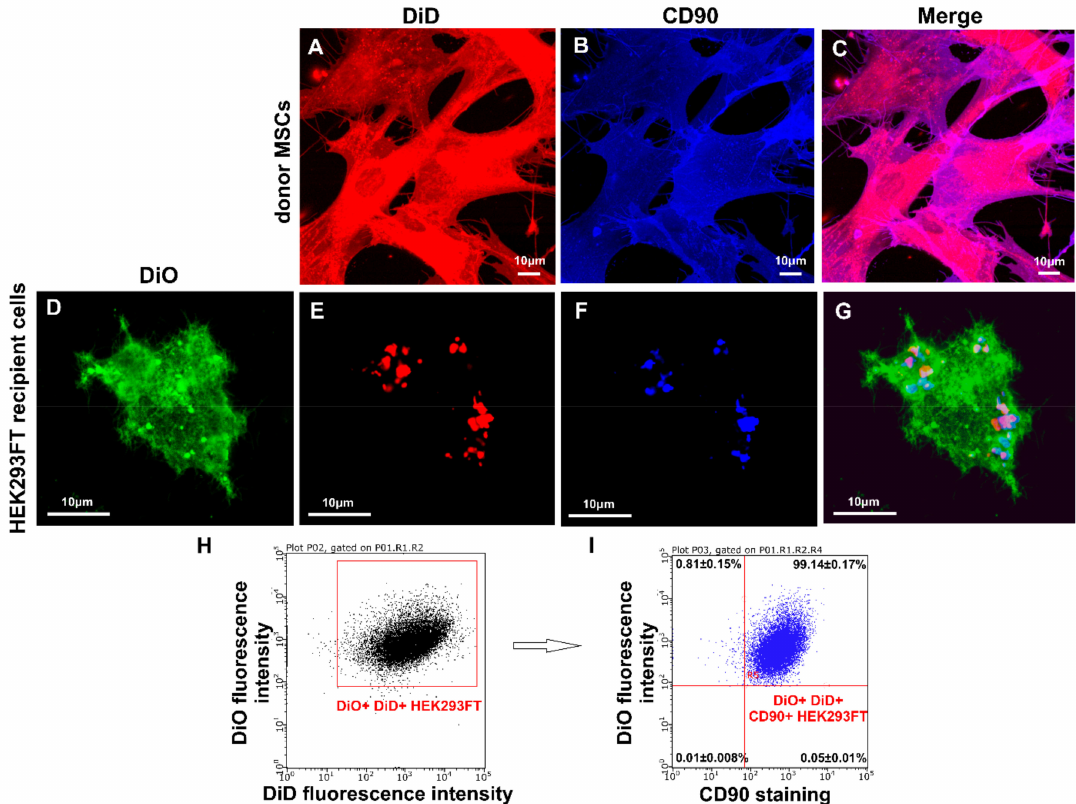
Figure 5. Analysis of CD90 transfer by CIMVs-MSCs to recipient HEK293FT cells. ( A–G )